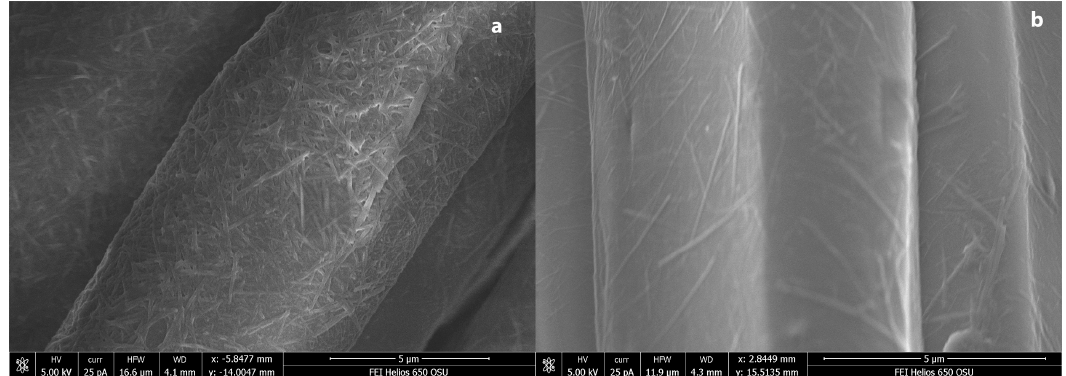
Figure 5. Surface of polyester fibers after dyeing via two different methods: ( a ) Ethanol-based ink dripping on polyester; ( b ) Ethanol-based ink immersion on polyester. Images taken with a FEI Helios 650.